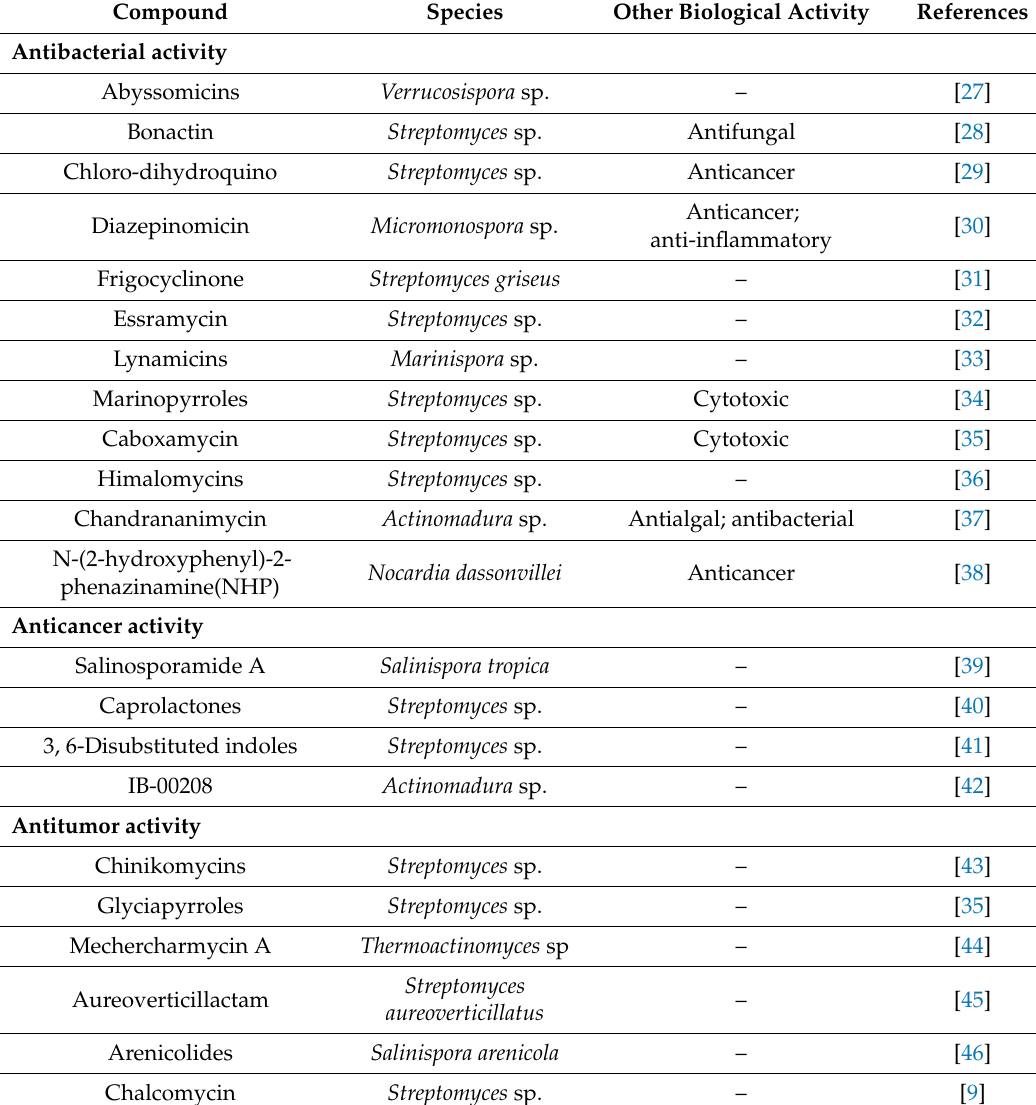
Table 2. Some secondary metabolites produced by marine